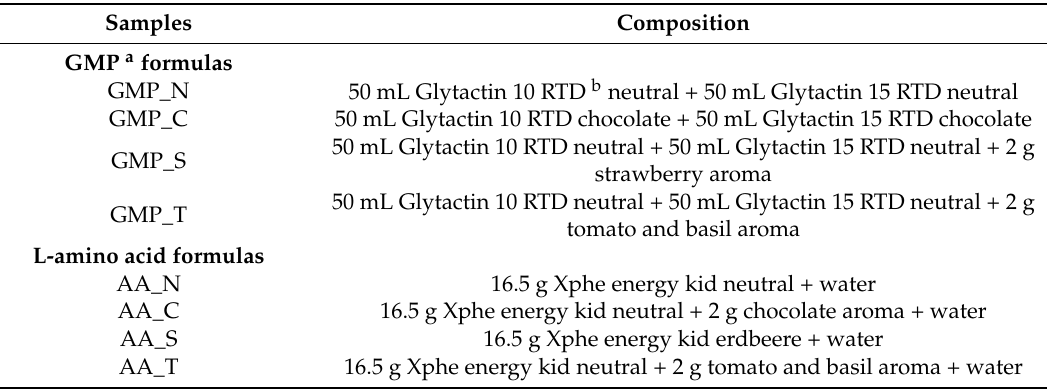
Table 2. Compositions of the eight